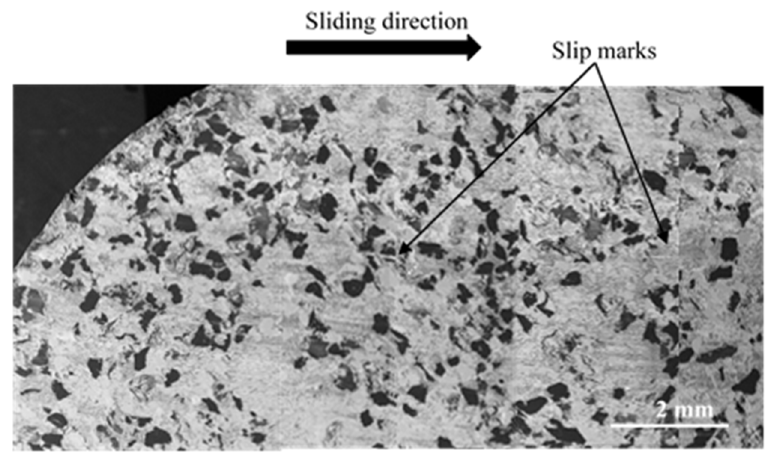
Figure 8. Distribution of powdered third-body and flat plates at IR and AR for FMFS (SEM and BSE).